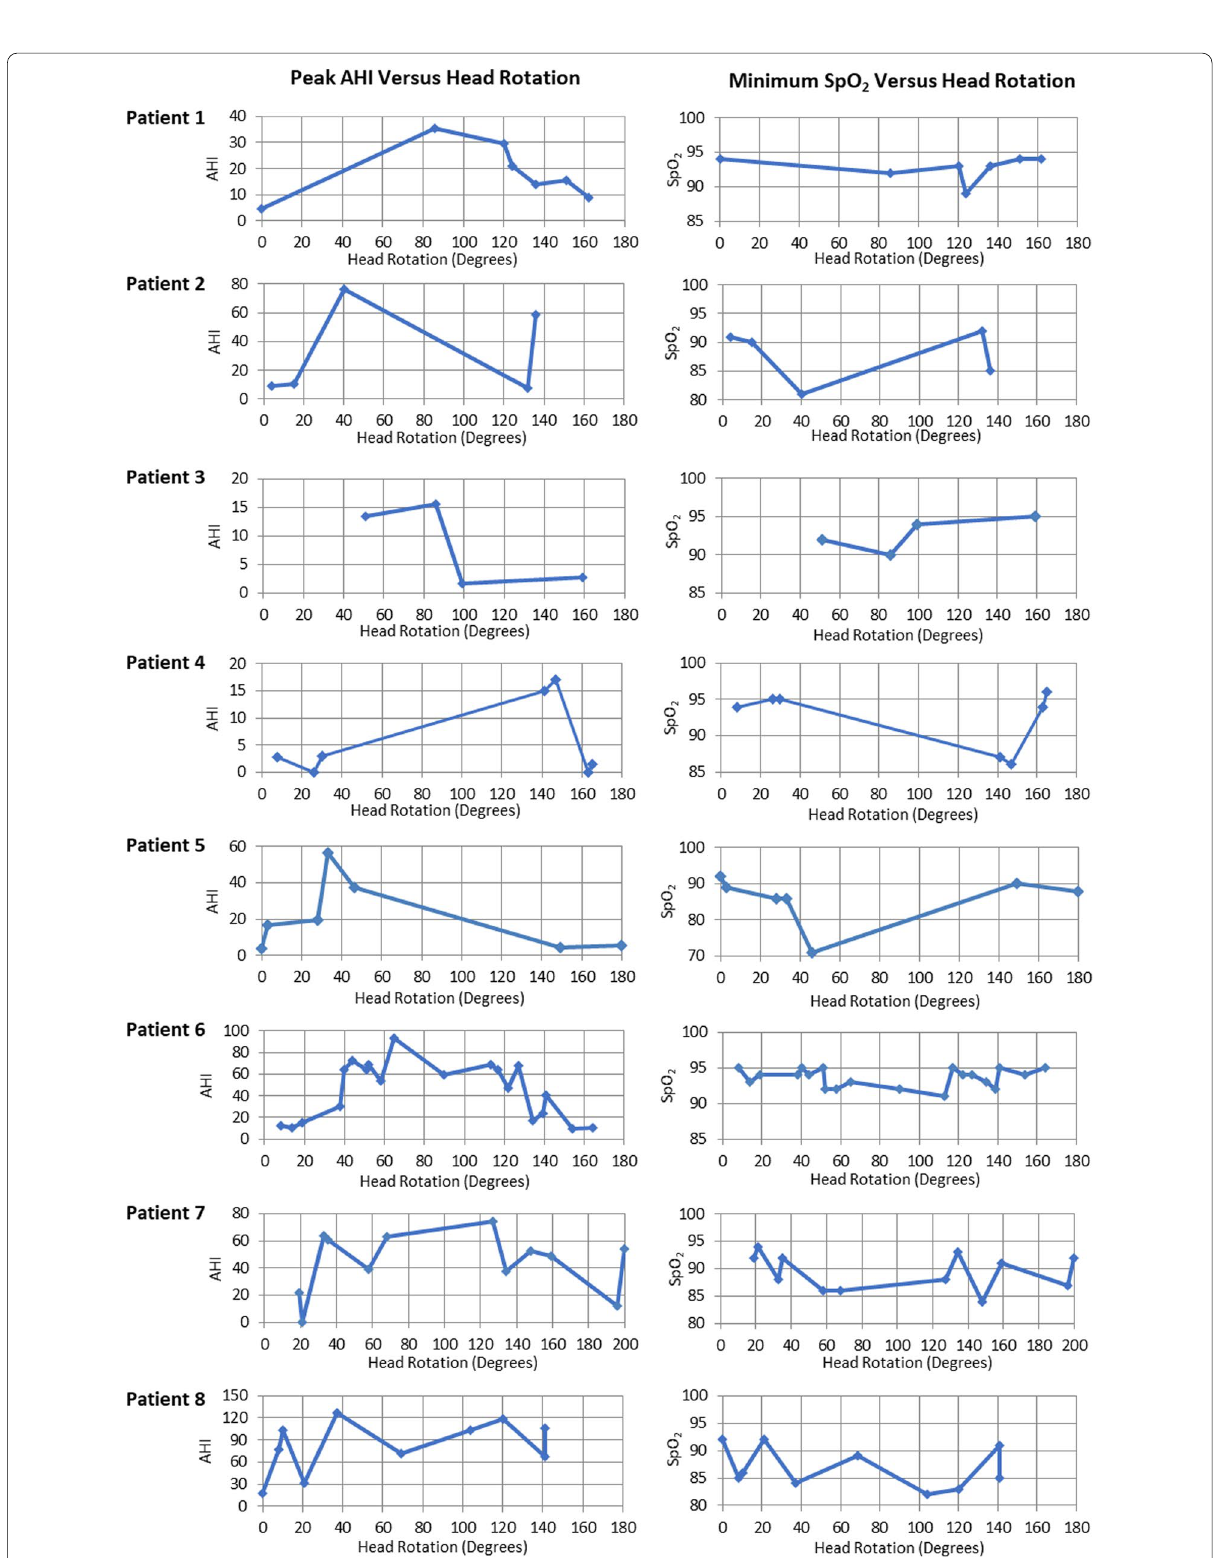
Fig. 2 Individual participants’ peak apnea-hypopnea index (AHI) and minimum oxygen saturation (SpO 2 ) by head rotation